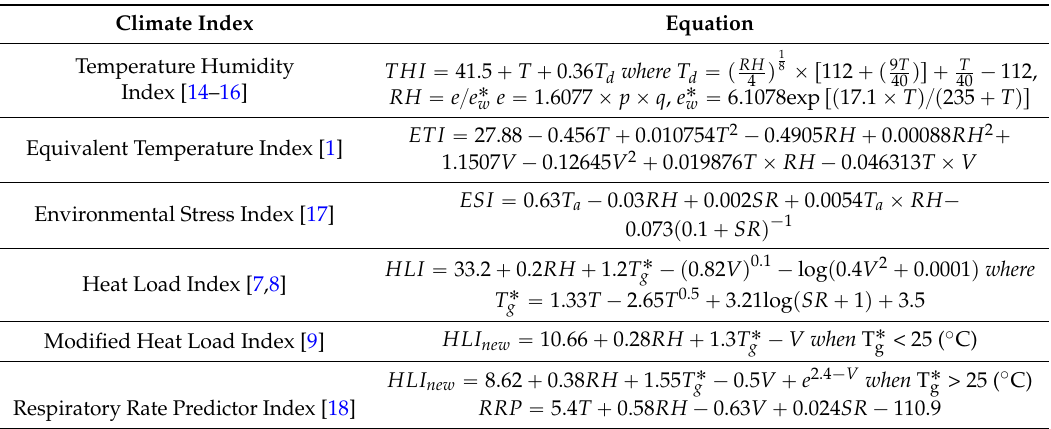
Table 3. Definition equations of the climate indices (THI, ETI, ESI, HLI, HLI new, and RRP) used for investigating the influence of environmental influences upon milk components in this